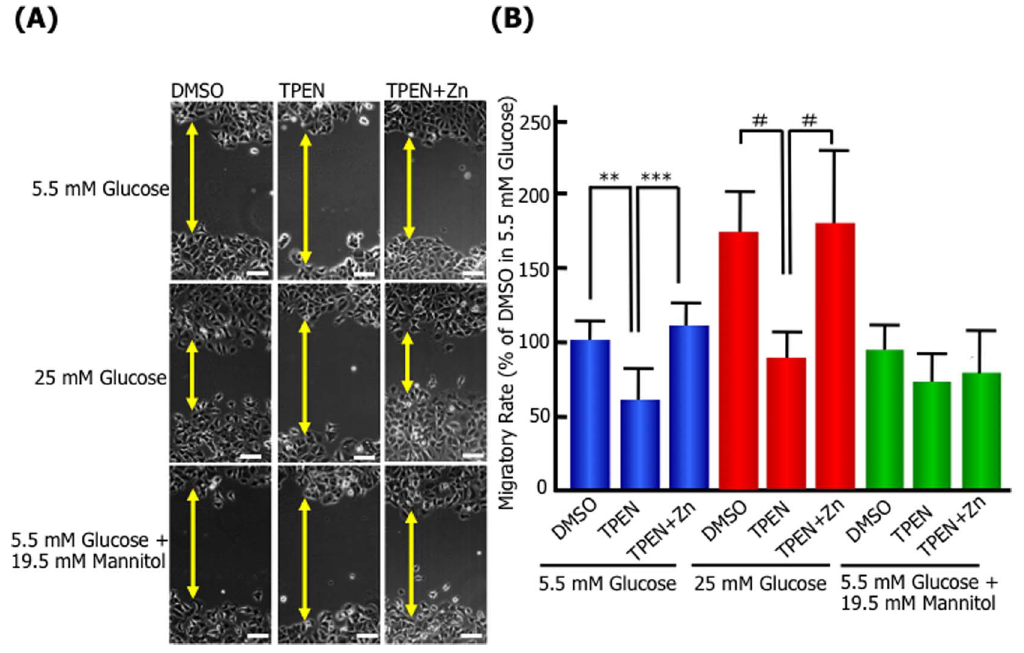
Figure 3. The effect of Zn 2 + -chelating reagent, TPEN on MCF-7 migration. A confluent monolayer of MCF-7 cells was scratched and then cultured in normal (5.5 mM), high (25 mM) D-glucose concentration, or an osmotic control (5.5 mM D-glucose plus 19.5 mM D-mannitol or D- fructose) medium in the absence or presence of 0.5 m M TPEN or 0.5 m M TPEN plus 5 m M ZnCl 2 . After 24 h, the wounded area was observed and photographed by microscopy. (A) Images at 24 h after scratching of each experimental condition. Arrowed lines represent cell-free zone in wounded area. Bars: 100 m m. (B) Migratory rates of each experimental condition. The quantity was normalized the wound closure area between 0 and 24 h against the wounded area at time zero and expressed as percentage of the migratory rate of MCF-7 cells incubated with the normal glucose concentration in the absence of TPEN. Data are presented as means 6 SD. ** p , 0.01, *** p , 0.001, # p , 0.0001, n=7–18.